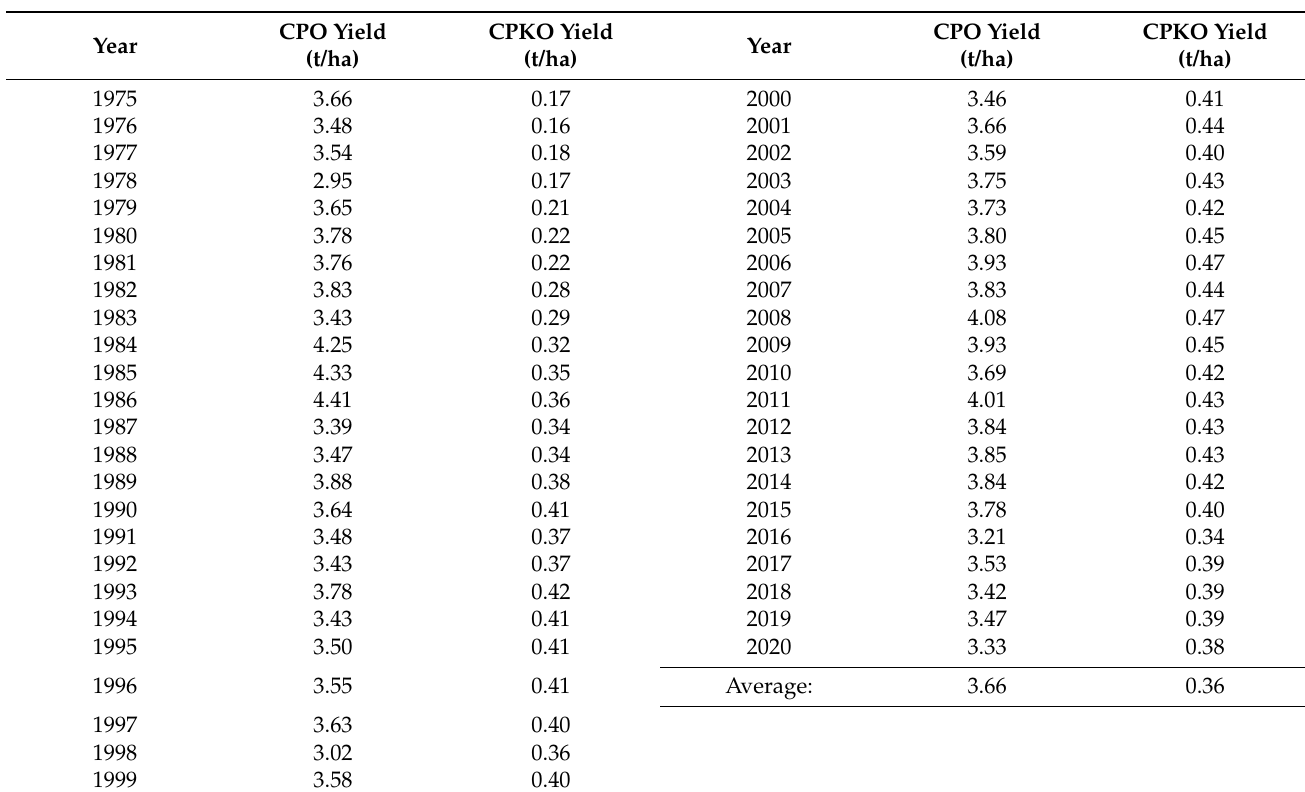
Table A1. Annual productivity of crude palm oil (CPO) and crude palm kernel oil (CPKO) from 1975 to 2020 in Malaysia